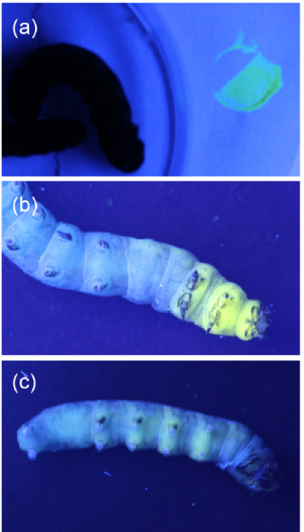
Figure 4. Fluorescence images of an S. littoralis larva. ( a ) Larva before injection (on the right: A spot of Lucifer Yellow on filter paper), ( b ) 10 min, and ( c ) 1.5 h after injection of Lucifer Yellow solution (5 µ L, 1 mg · mL − 1 ) into the larval foregut.